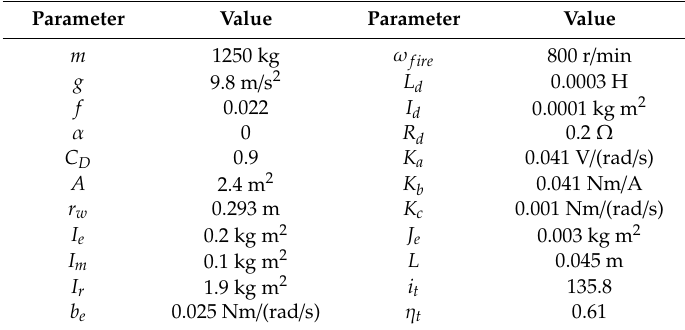
Figure 7. Driver’s demand torque. Table 2. Main parameters of the simulation model.